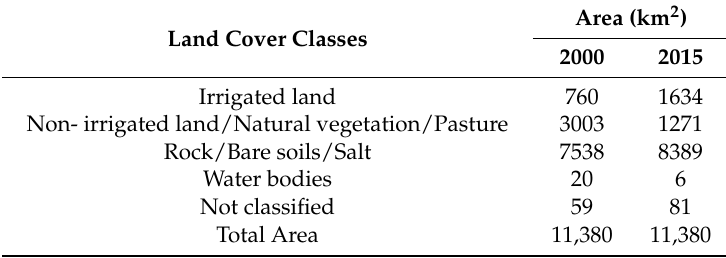
Table 8. Land cover changes computed by using classified Landsat images (see Figure 7).